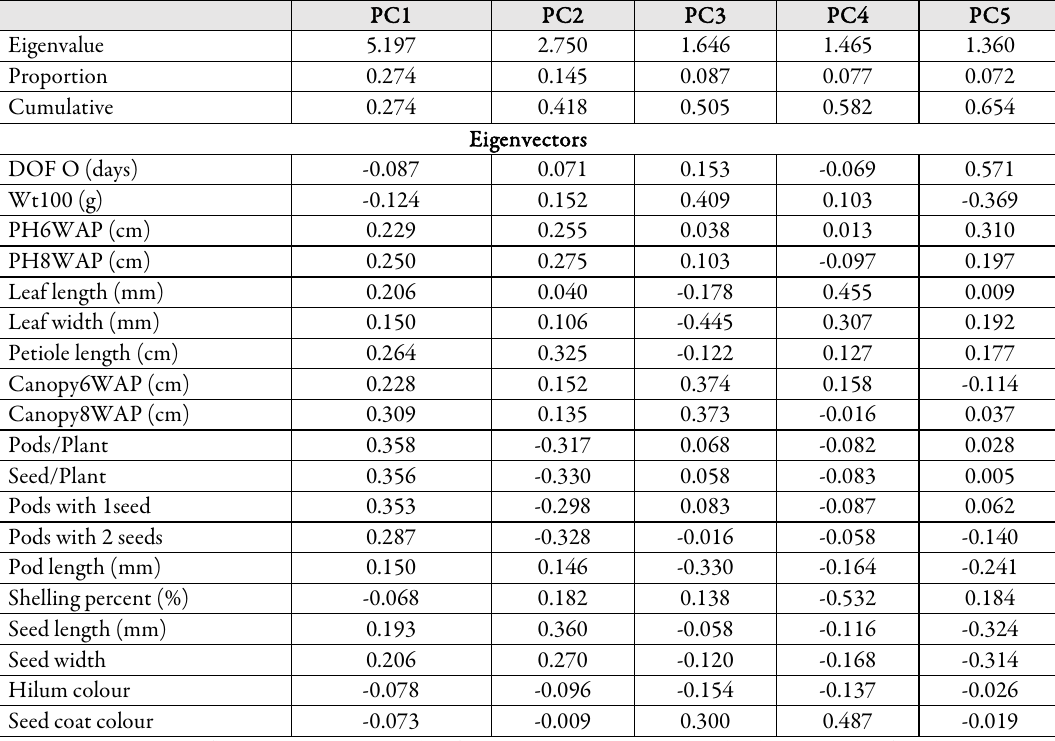
Table 3. Eigenvalues, variance components of five PC axes and the different proportional contributions of the 19 traits as Eigenvectors loadings in the five PC